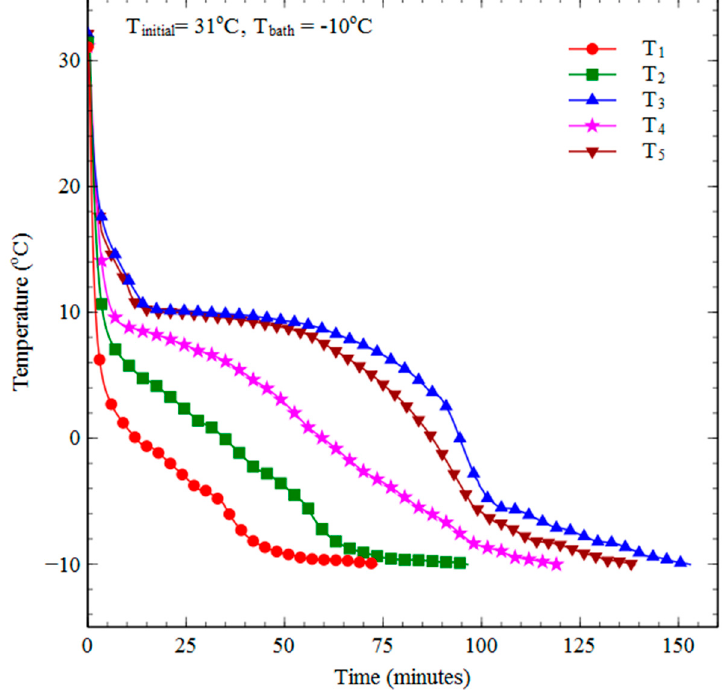
Figure 6. Temperature change at di ff erent locations as a function of time during solidification of pure PCM.